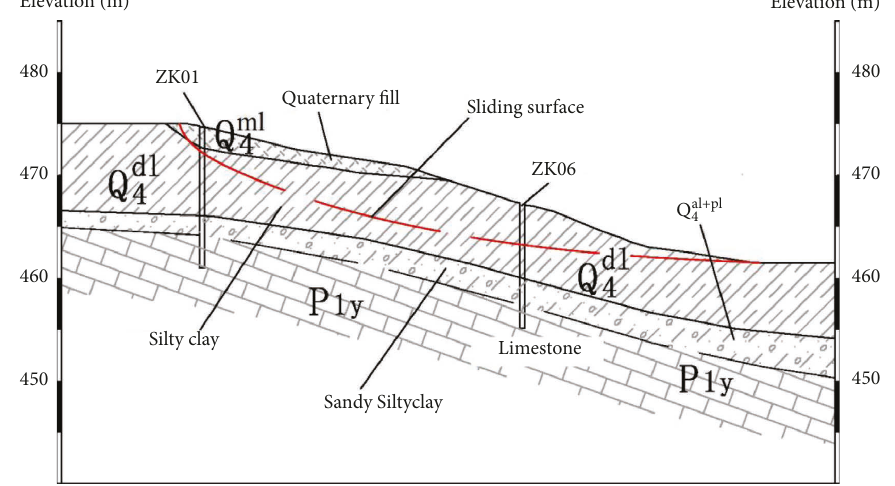
Figure 18: Engineering geological profile of the landslide. Table 4: Physicomechanical parameters of landslide and stability calculations.